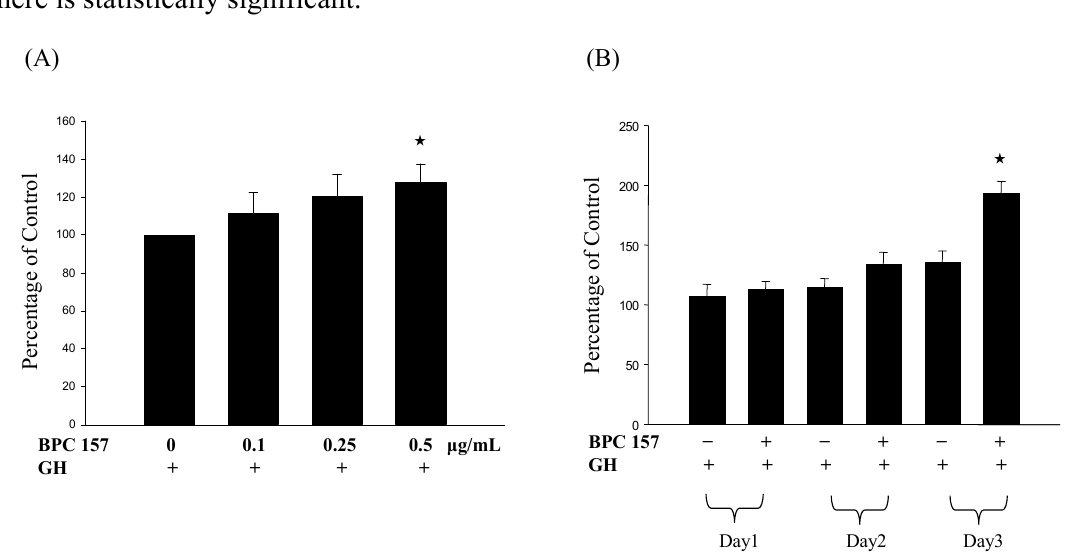
Figure 2. Growth hormone increased the cell number of BPC 157-treated tendon fibroblasts. Tendon fibroblasts at 50%–60% confluency were pretreated with BPC 157 at concentrations of 0, 0.1, 0.25, 0.5 μ g/mL for 24 h ( A ) or 0.5 μ g/mL for one to three days ( B ). After BPC 157 pretreatment, 0.1 μ g/mL growth hormone was added for another 24 h and then MTT assay was performed. Experiments were done in triplicate. The “ ★ ” would be applied if there is statistically